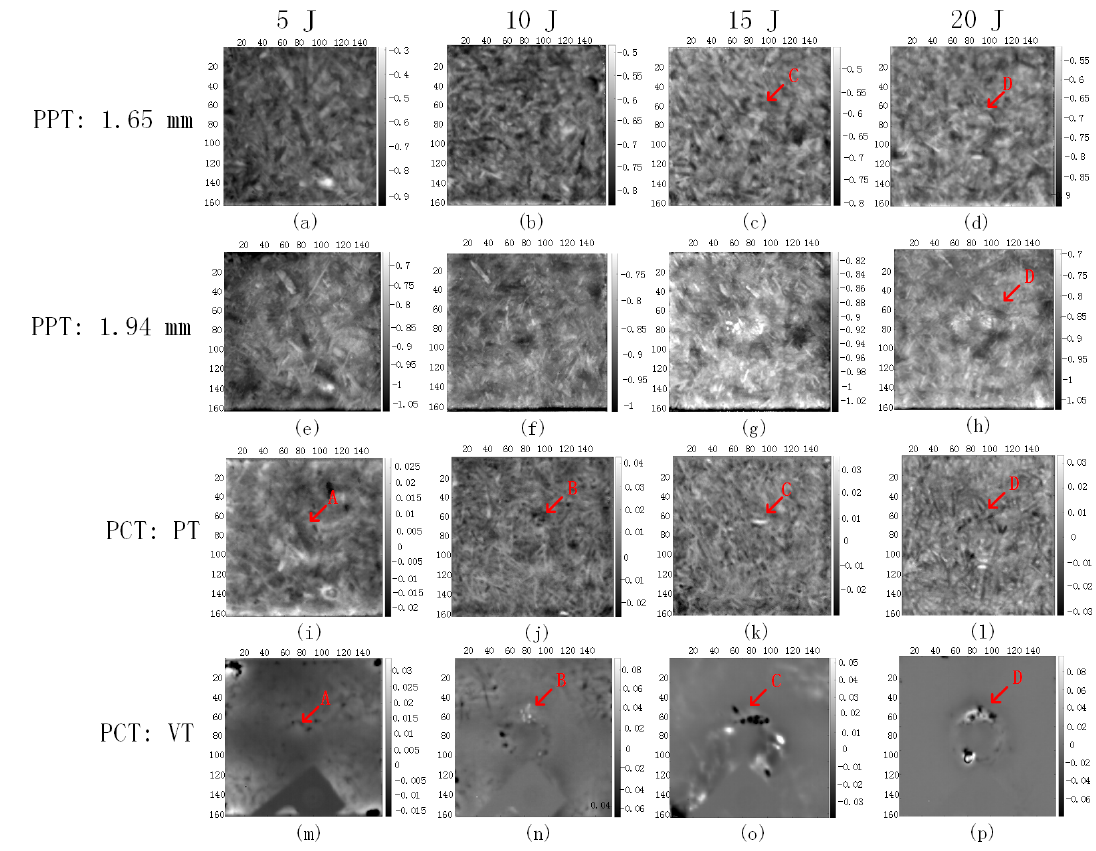
Figure 13. IRT for the SCB laminates after PPT and PCT processing.